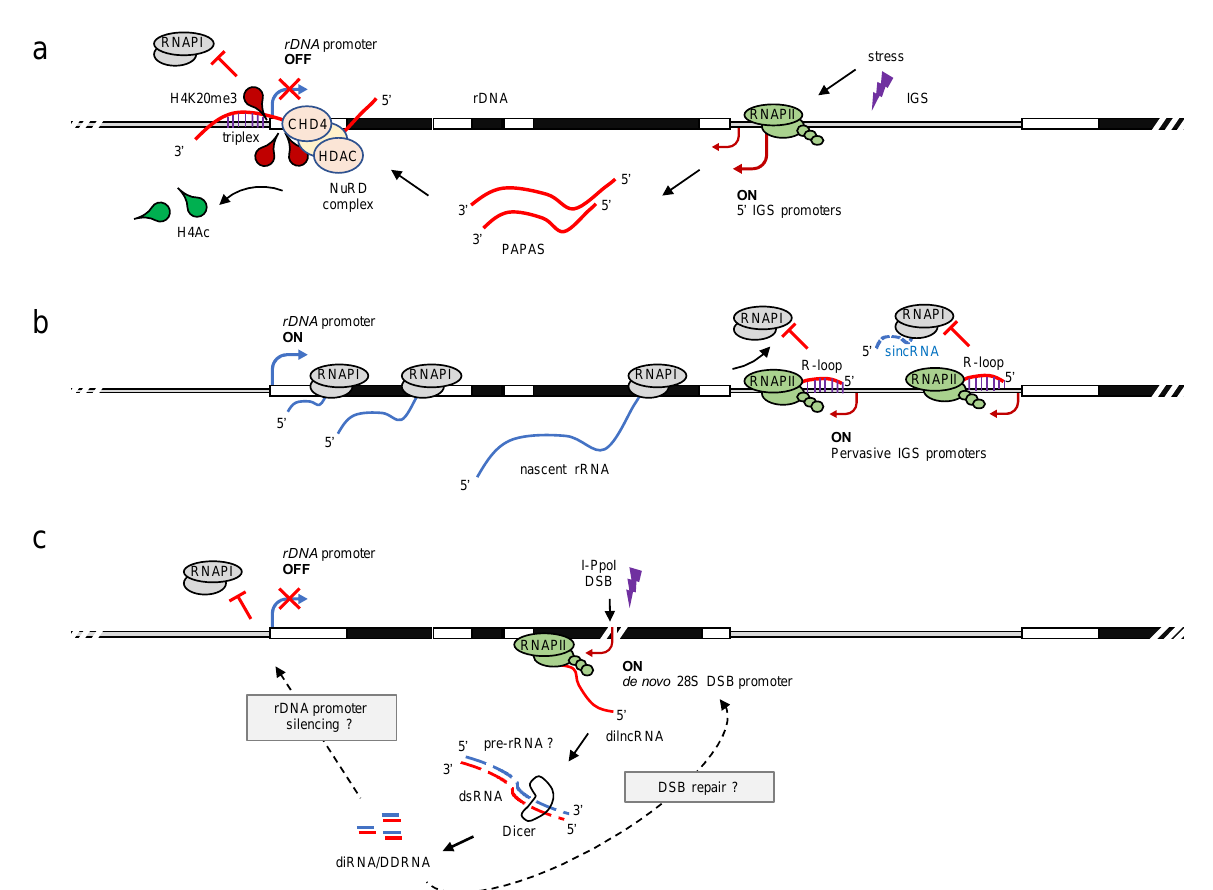
Figure 3. Regulation of rRNA synthesis by cis-acting lncRNA. ( a ) lncRNA-mediated downregulation of rRNA synthesis. Cellular stress activates transcription of promoter and pre-rRNA antisense transcripts (PAPAS, red) from random antisense RNAPII promoters (red arrowhead) in the 5′ region of the IGS. PAPAS are tethered to the rDNA enhancer via triple-helix formation and interact with chromatin remodelling factors such as the chromodomain-helicase-DNA-binding protein 4 (CHD4) and histone deacetylases (HDAC) to form the nucleosome remodelling and deacetylation (NuRD) complex. NuRD represses rRNA synthesis via formation of histone H4 lysine-20 trimethylation (H4K20me3) and removal of histone H4 acetylation (H4Ac) marks at the rDNA promoter (blue arrowhead). ( b ) lncRNA-mediated surveillance of rRNA synthesis. Pervasive transcription of RNAPII across the IGS produces antisense lncRNA (red) that form RNA-DNA hybrids (R-loops). The formation of nucleolar R-loops prevents transcription of the IGS by RNAPI. However, the disruption of nucleolar R-loops enables the recruitment of RNAPI to the IGS and results in the synthesis of sense intergenic non-coding RNA (sincRNA; dashed blue) that mimic nucleolar stress. The suppression of sincRNA transcription maintains the bona fide synthesis of nascent rRNA (blue). ( c ) Nucleolar lncRNA in the DNA damage response. The locus-specific induction of a DNA double-strand break (DSB) in the 28S rDNA by the endonuclease I-PpoI triggers the synthesis of damage-induced lncRNA (dilncRNA) by RNAPII from a de novo antisense promoter (red arrowhead). A subset of dilncRNA forms double-stranded (ds)RNA and is processed by the endonuclease Dicer into small damage-induced RNA (diRNA or DDRNA). The functional relevance of nucleolar diRNA/DDRNA is currently unclear, but may include the recognition and repair of the 28S rDNA DSB, silencing of the rDNA promoter (blue arrowhead), and/or downregulation of RNAPI transcription (red block) in a small RNA-dependent manner (?). The transcription units are not in scale.